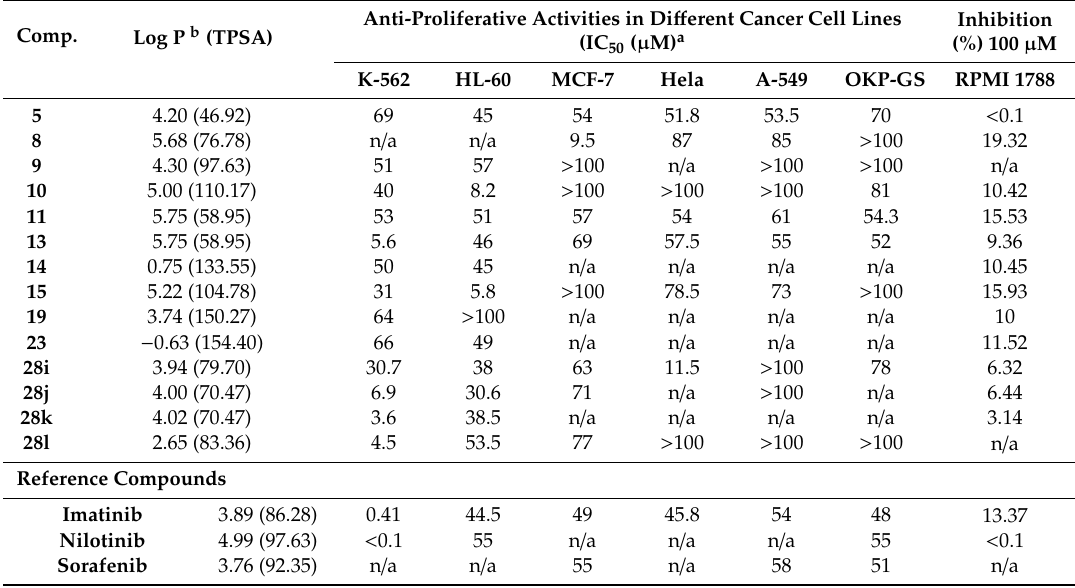
Table 2. In vitro anti-proliferative activities of targets compounds against cancer cells (K-562, HL-60, MCF-7, Hela, A-549, OKP-GS) and human normal cells (RPMI 1788).